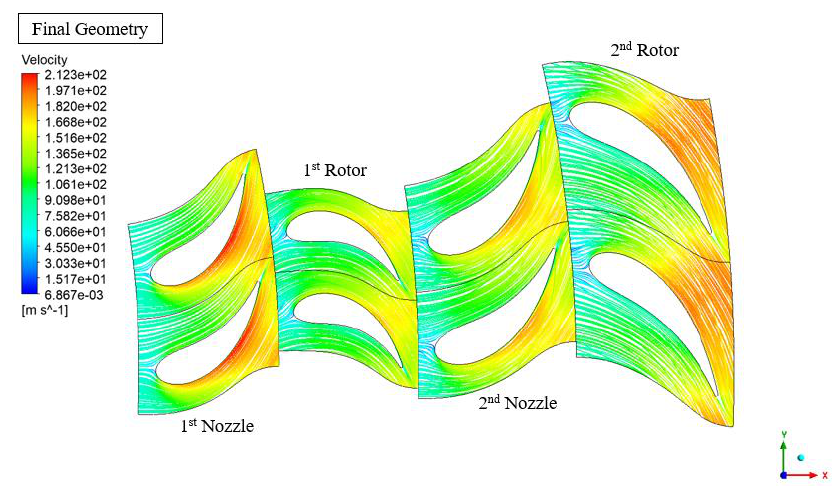
Figure 17. Streamline of the initial geometry.